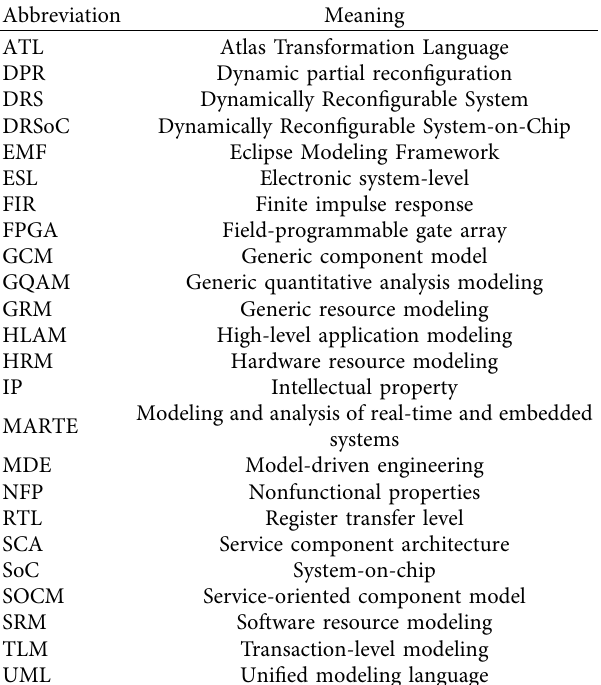
Table 1: List of abbreviations used in this research